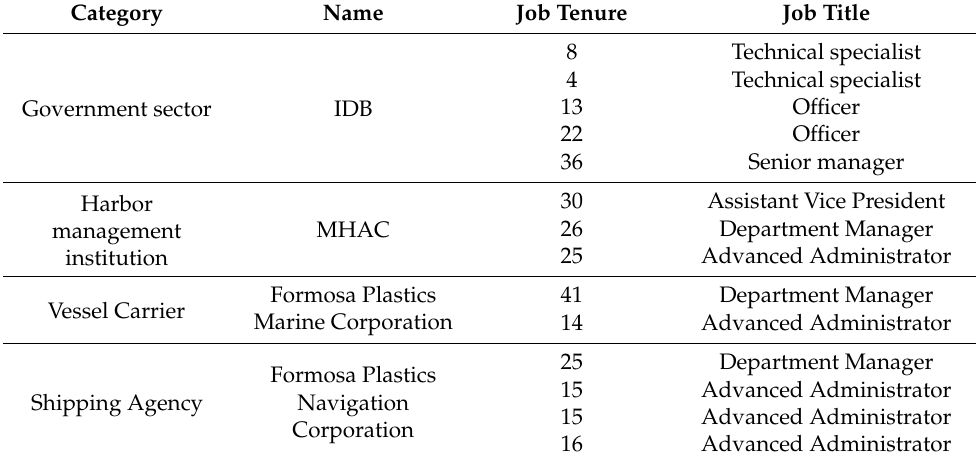
Table 4. The list of questionnaire and interview